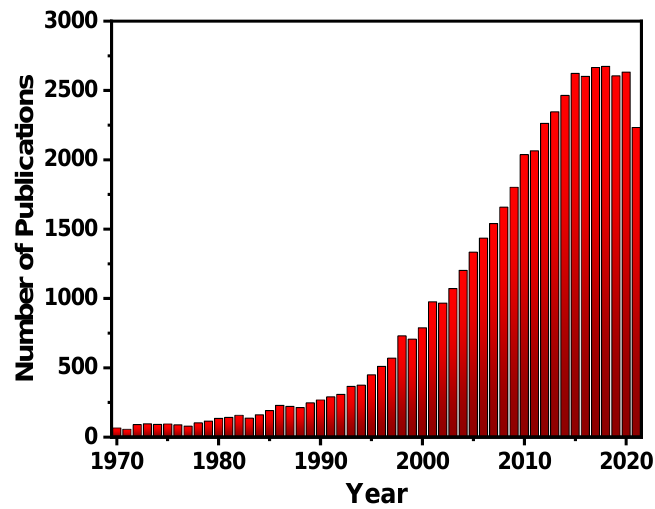
Figure 2. The number of publications per year on (FPs) (obtained from Scifinder n ).